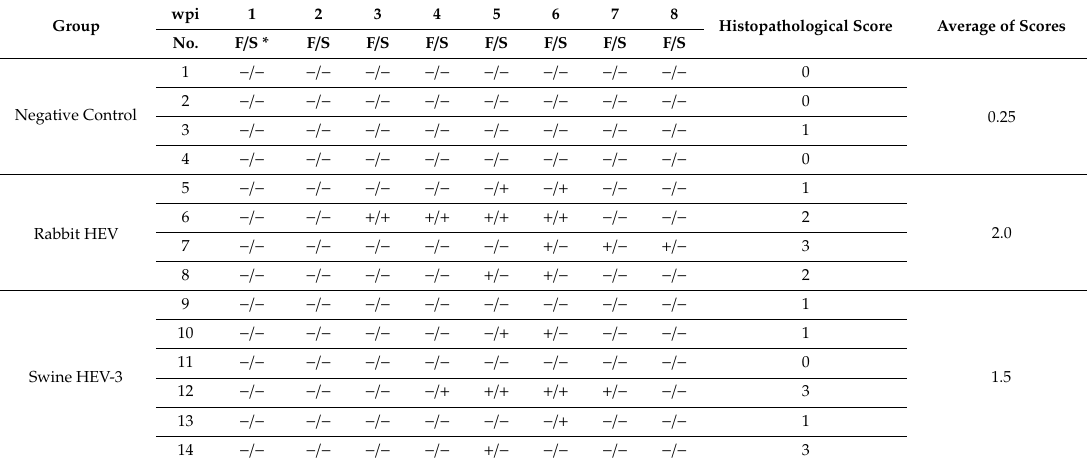
Table 1. Detection of HEV in serum and fecal samples and evaluation of histopathological lesions in the livers of rabbits.